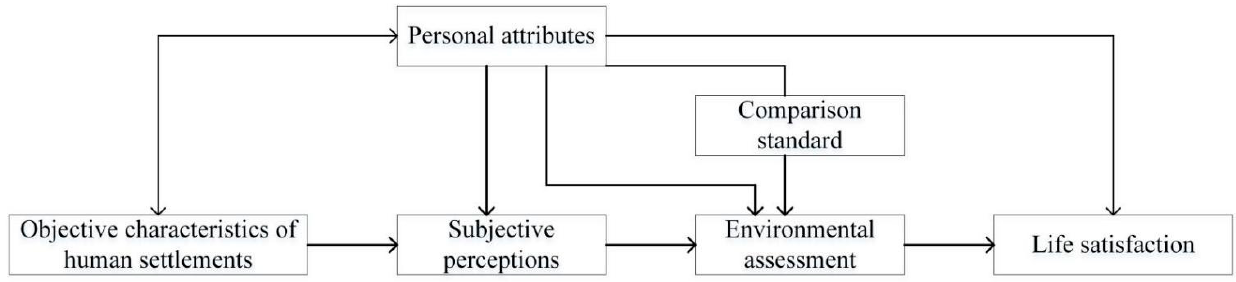
Figure 3. Campbell’s Model.